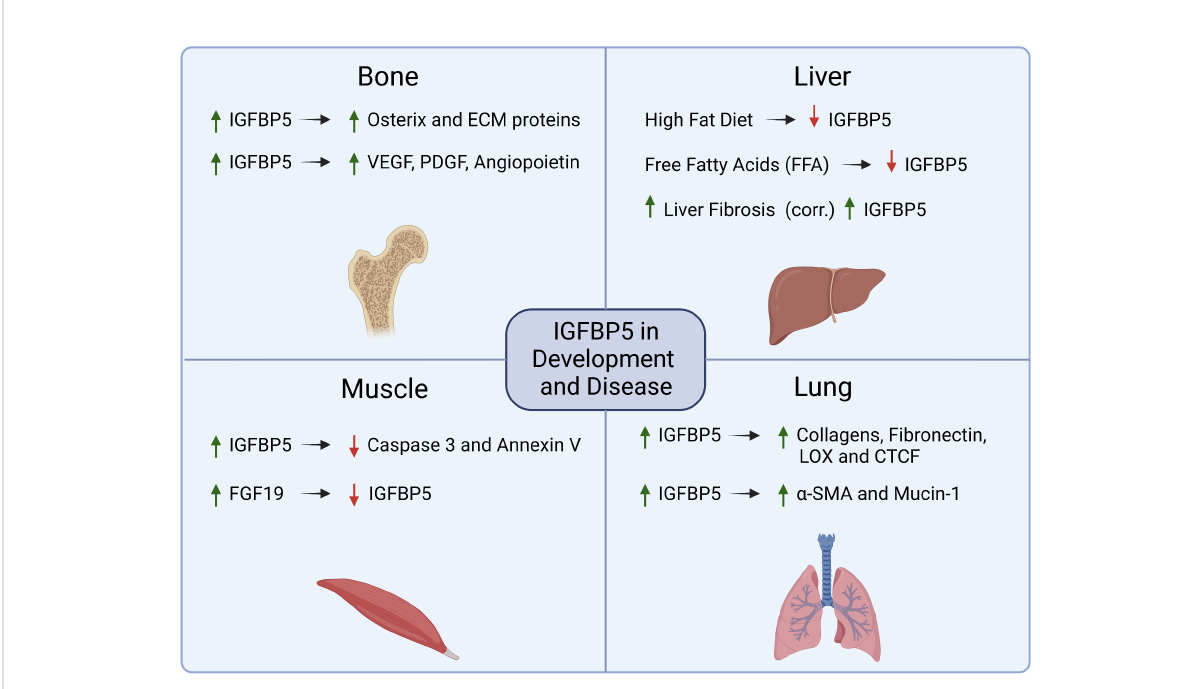
FIGURE 4 Summary of mechanisms that are regulated by IGFBP5 or which regulate IGFBP5 in physiology and non-cancer